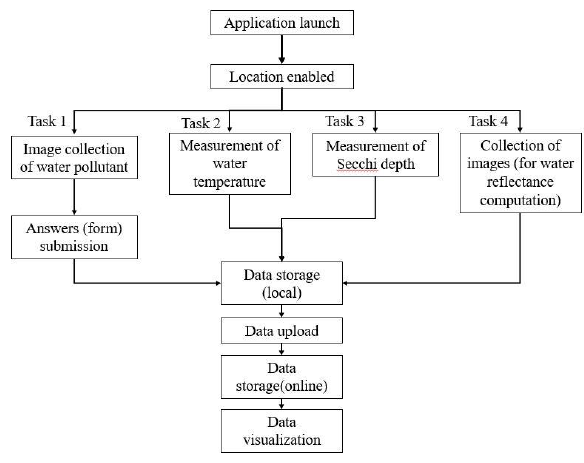
Figure 10: The workflow of data-collection in the application To fulfill those two tasks, additional equipment is mandatory (thermometer and Secchi disk), which will be provided for free to specific groups of users who will agree and who will have the required means (e.g. vessels) and level of expertise. Task 4 is devoted to image collection of the water surface, under certain conditions. Those conditions are related to the orientation of the smartphone with respect to the sun and to the inclination of the smartphone with respect to the water